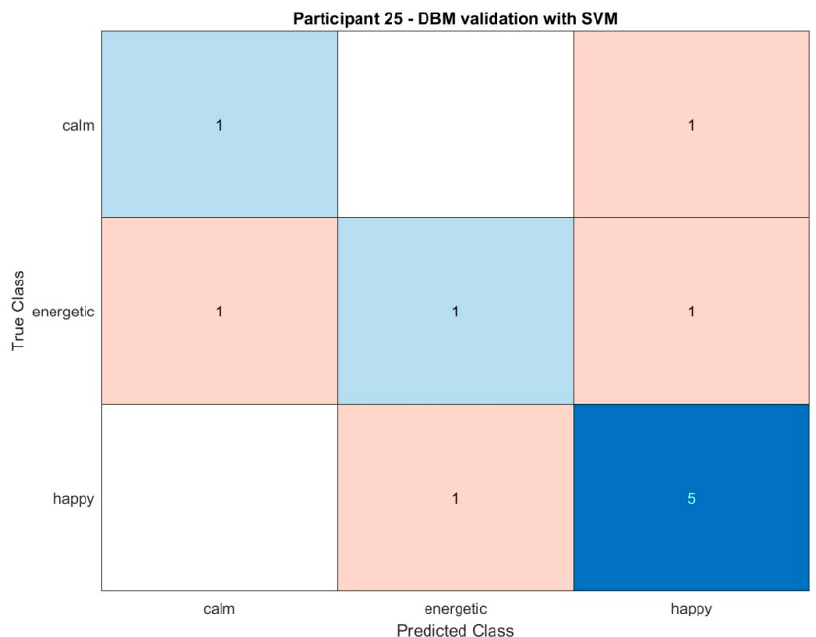
Figure 8. Confusion matrix of the classification of participant P25. The vertical axis represents the true class of the labels added by the participant. The horizontal axis represents the labels that were predicted by the classification algorithm. Each number, so every colour, indicates how many times each true class was predicted as each emotion on the horizontal axis.